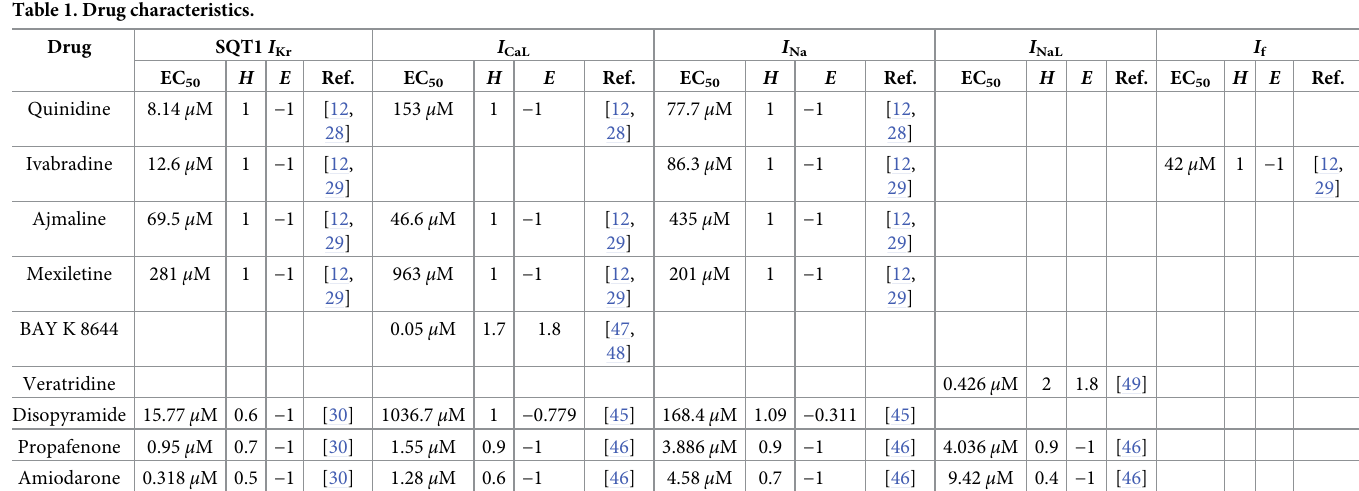
Characteristics of selected drugs obtained from literature in the form of EC 50 -values (1/ ε ), Hill coefficients ( H ) and maximum effects ( E ) for the modified I Kr current affected by the SQT1 mutation and for the wild type I CaL , I Na , I NaL and I f currents, see